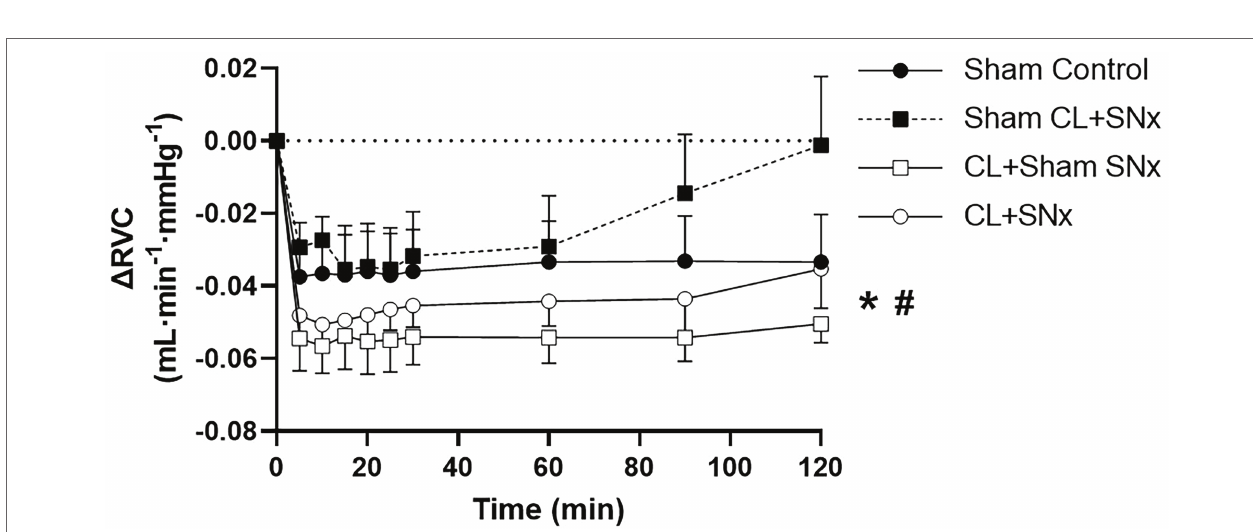
FIGURE 4 | Heart failure exacerbated the RVP-induced fall in renal vascular conductance. Acute RVP elevation induced a significant fall in RVC from baseline in CL + SN x ( n = 12) and CL + Sham SN x ( n = 9) groups (one-way RM ANOVA, baseline vs. timepoints, * p < 0.05); there was no statistically significant fall in RVC in Sham CL + SN x ( n = 6) or Sham Control ( n = 6) groups. The magnitude of the change in RVC was greater in the groups subjected to coronary artery ligation (CL or Sham CL, three-way ANOVA, # p < 0.05). The magnitude of RVC decrease was comparable between CL + Sham SN x and CL + SN x (SN x or Sham SN x within CL, three-way